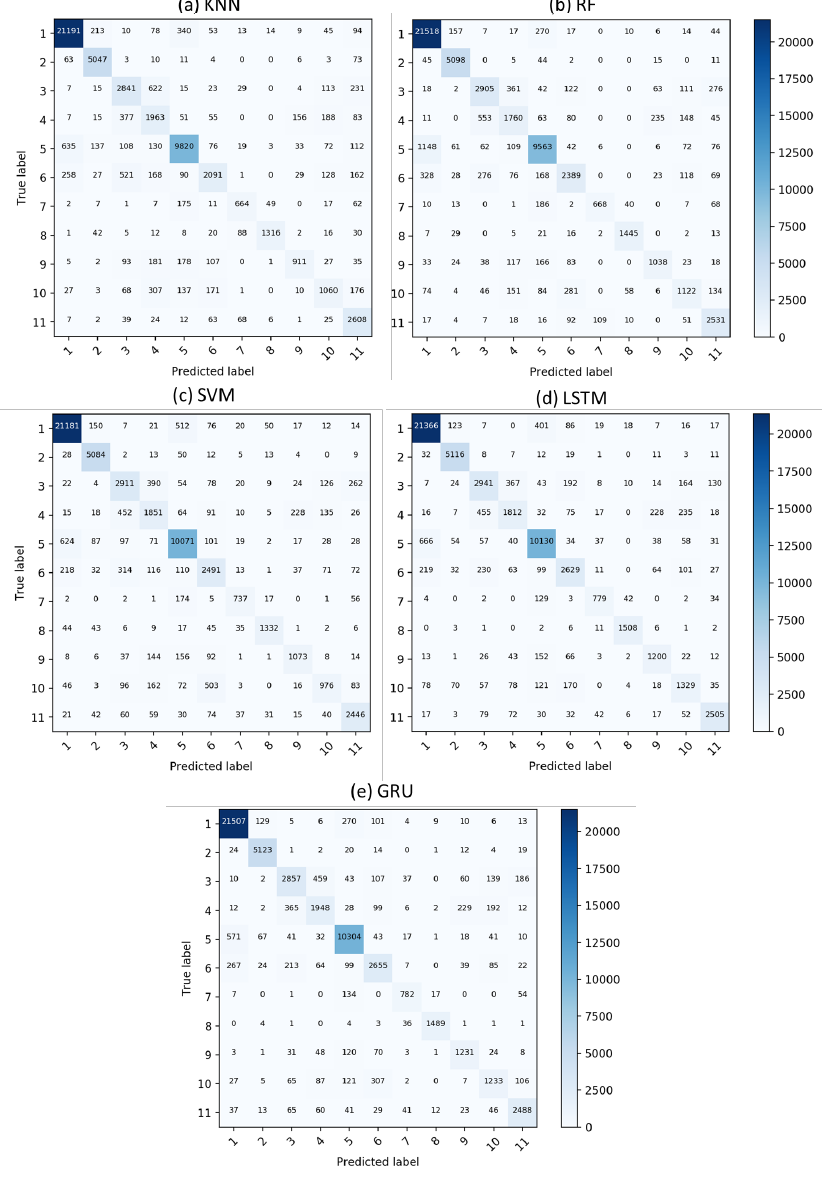
Figure 7. Confusion matrices on the SAR Sentinel-1 time series data of the different approaches: ( a ) KNN , ( b ) RF ; ( c ) SVM ; ( d ) LSTM and ( e ) GRU . The name of the labels: (1) rice; (2) sunflower; (3) lawn; (4) irrigated grassland; (5) durum wheat (winter); (6) alfalfa; (7) tomato; (8) melon; (9) clover; (10) swamps; and (11)